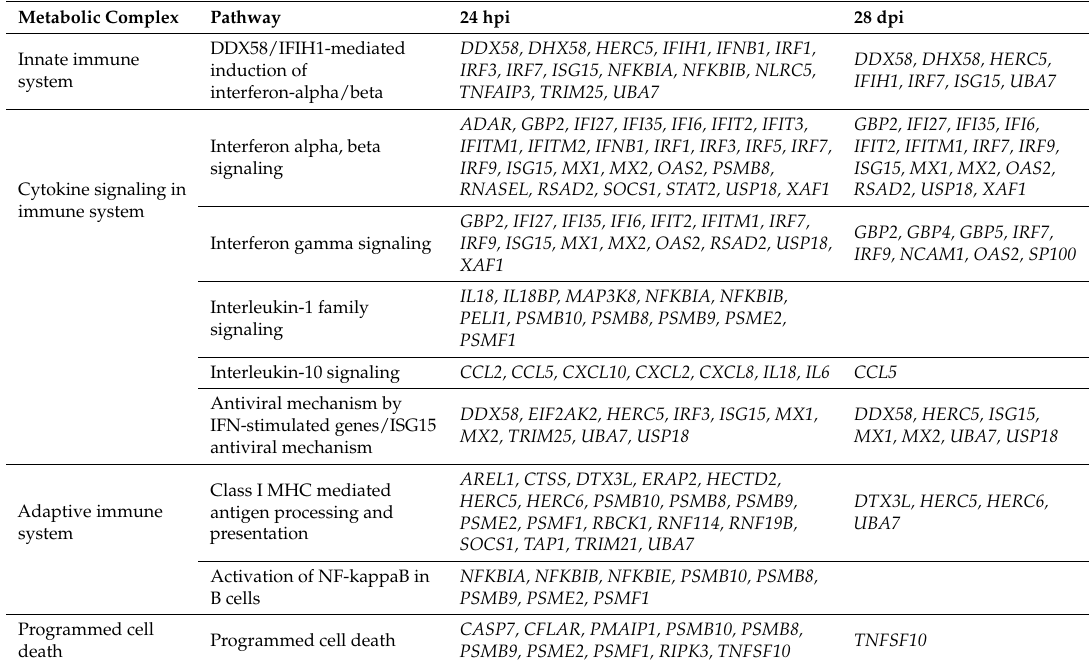
Table 1. Selected enriched pathways and corresponding genes during acute and persistent FMDV infection.